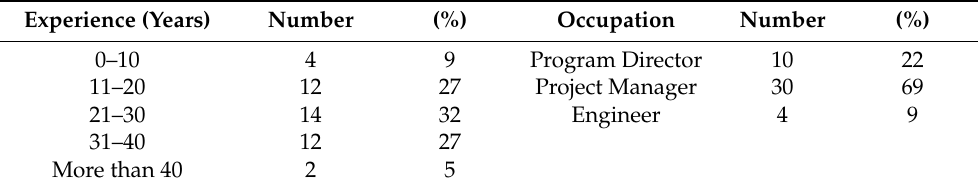
Table 1. Respondents’ Demographic Information.